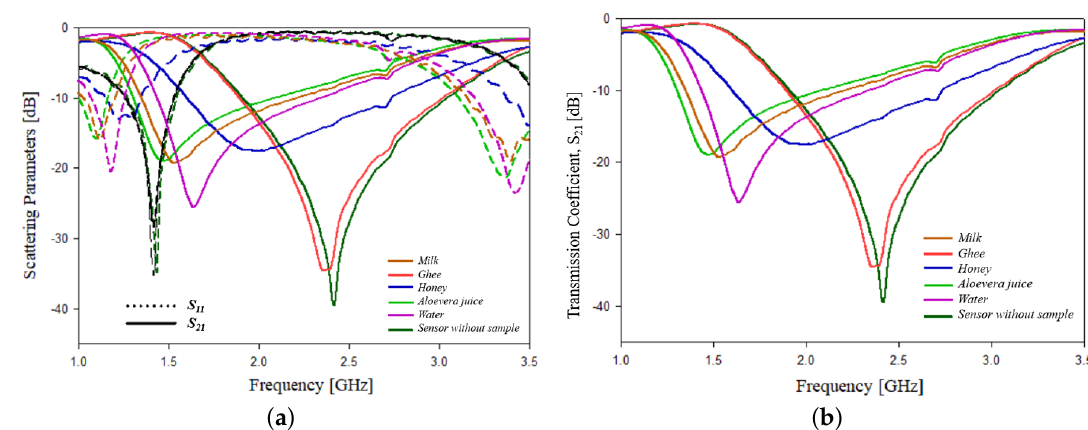
Figure 24. Senor testing in liquid samples.